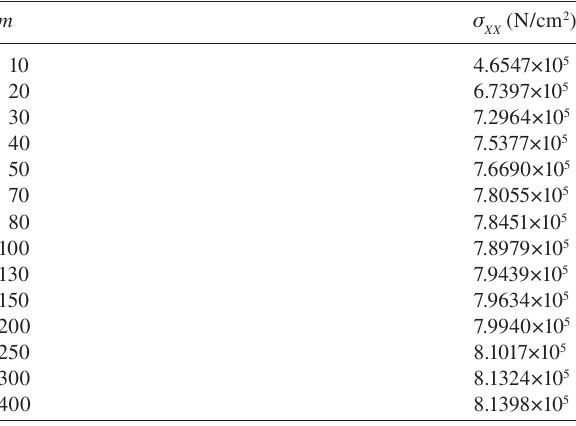
Figure 6 Dimensionless normal stress distributions along the beam thickness at fi xed end for ( – – – – ) k = 0, ( – – – ) k = 0.5, (------) k = 1, ( – – – ) k = 2.